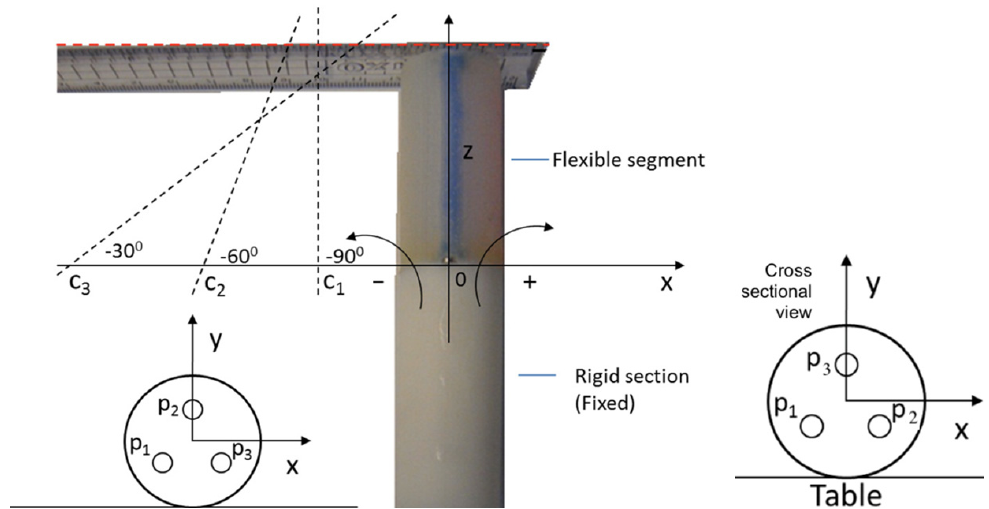
Figure 11. Test rig for the evaluation of the bending sensor performance. The ruler attached at the top of the flexible module allowed measuring the bending angle. During calibration, the angular ruler positions were related to the fibre-optic measurements. After calibration the fibre-optic measurements were a good predictor of bending angles [38].